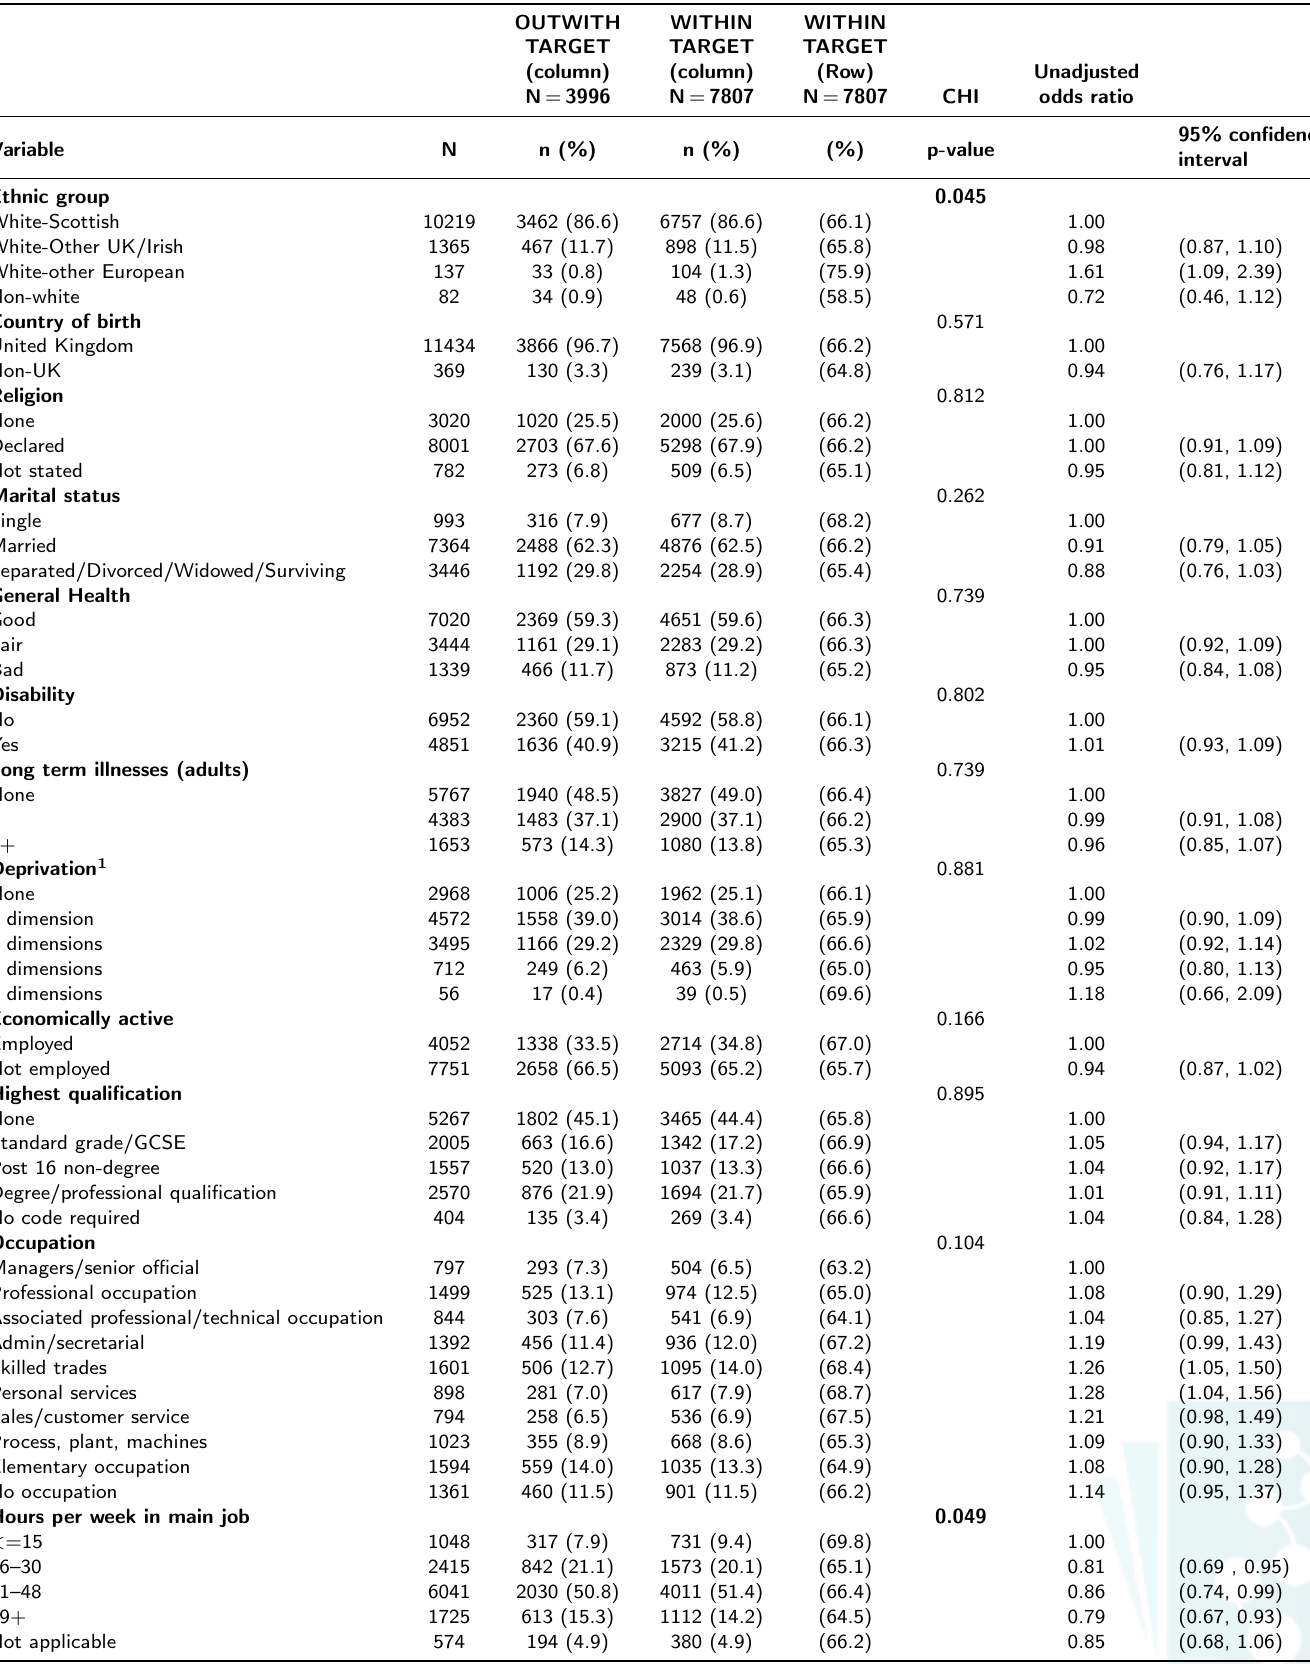
Table 3: Census characteristics by TIMELY TREATMENT (Treatment began within 62 days of GP referral) OUTWITH WITHIN WITHIN TARGET TARGET TARGET